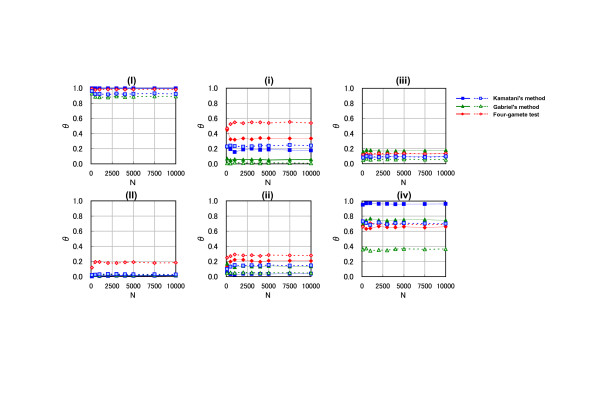
The effect of the number of simulation repeats on haplotype block characteristics under different block definitions: θ profiles versus the number of repeat times (n). The sample size (x) was adjusted by fixing it at 725 (solid lines) or 50 (dashed lines). The labels of analyzed SNPs intervals are identical to those in Figure 1. The number of repeat times (n) is shown on the horizontal axis. The simulation was repeated 10,000 times (N = 10,000) from 1, 100, 500, 1,000, 2,000, 3,000, 4,000, 5,000, and 7,500 times. θ profiles (the ratio of times to N times when simulating the transition zone of haplotype block) are shown on the vertical axis. The three labels represent different haplotype block definitions: blue square, Kamatani's method; green triangle, Gabriel's method; red diamond, four-gamete test.